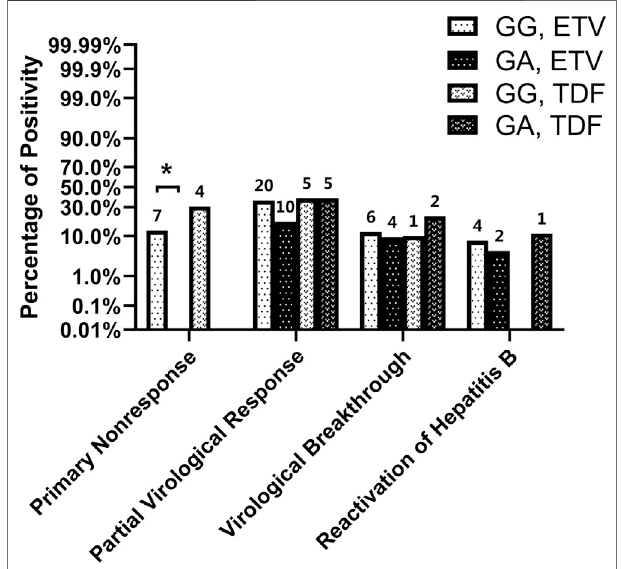
FIGURE 3 | Virological outcome of patients using ETV or